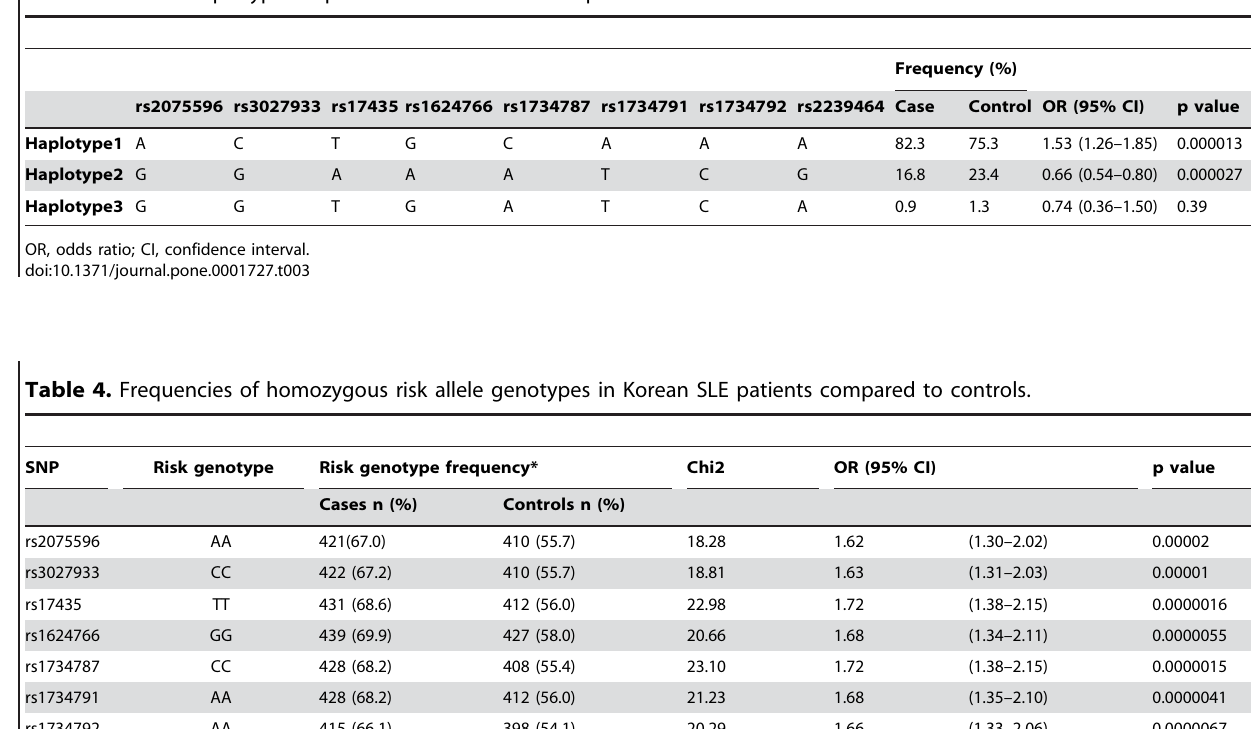
Table 3. MECP2 haplotype frequencies in the Korean SLE patients and